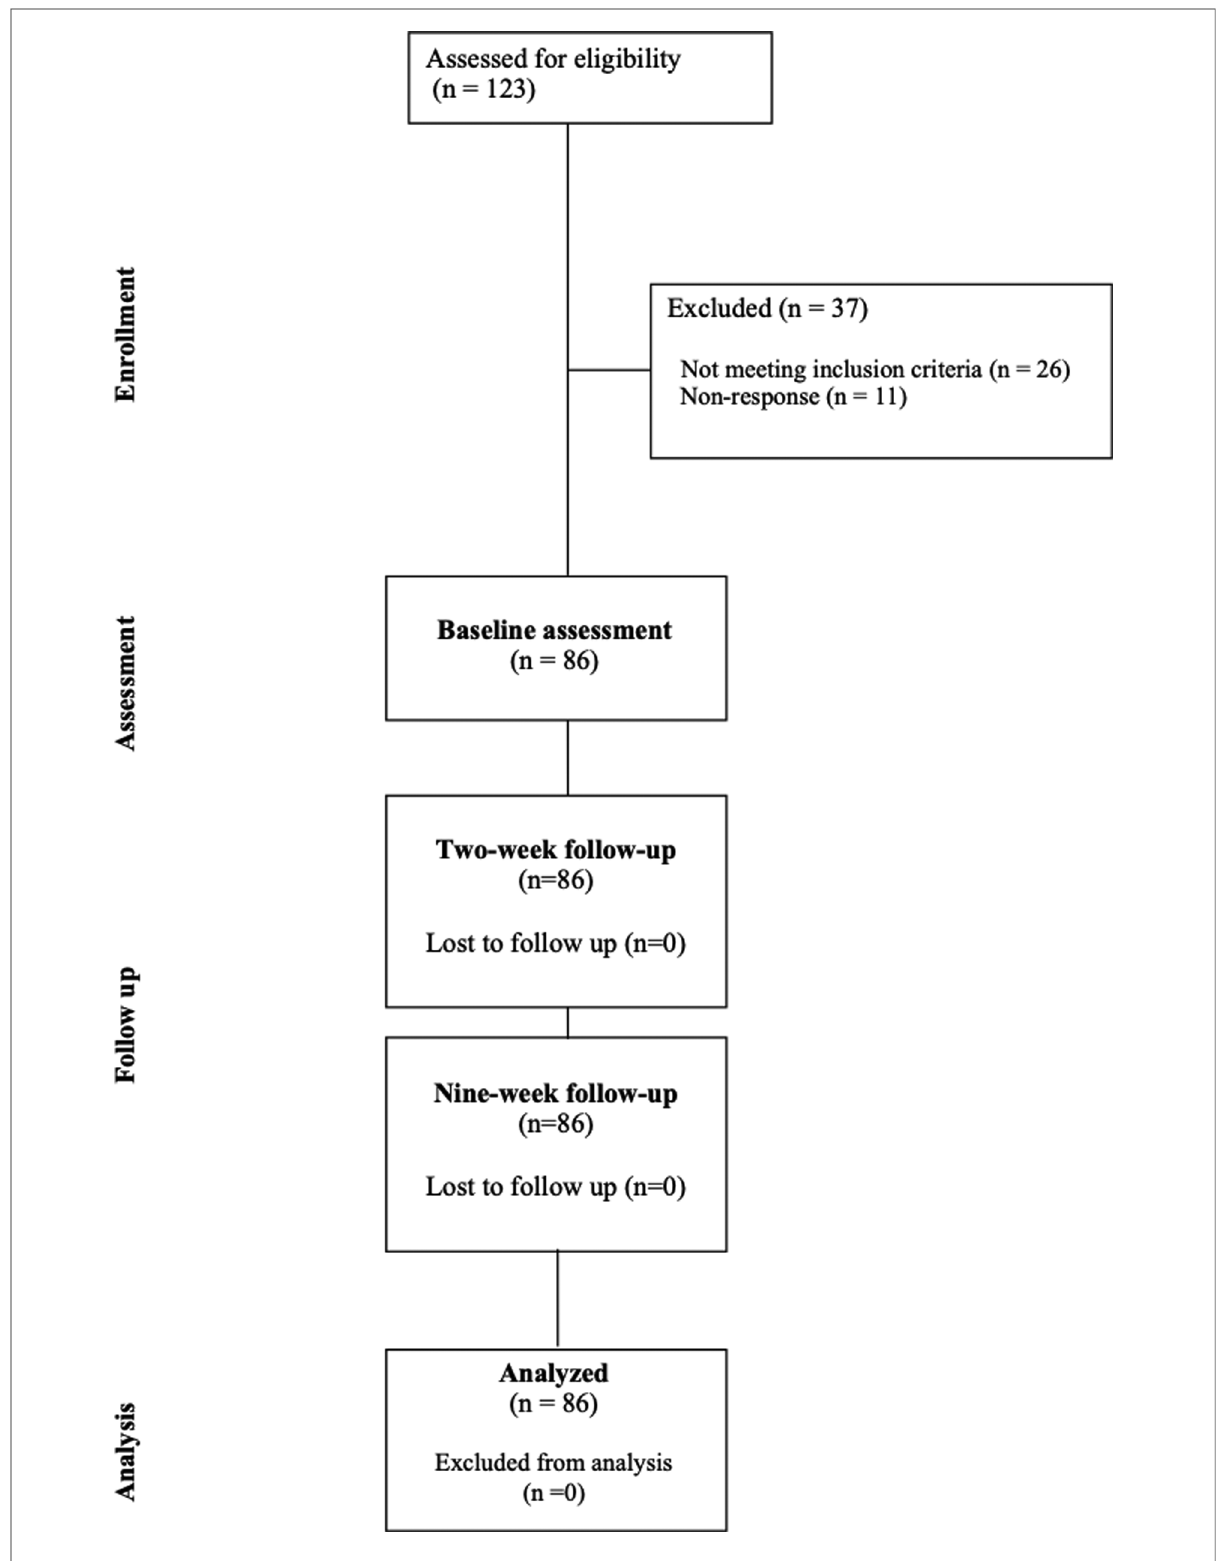
FIGURE 2 Participant fl ow